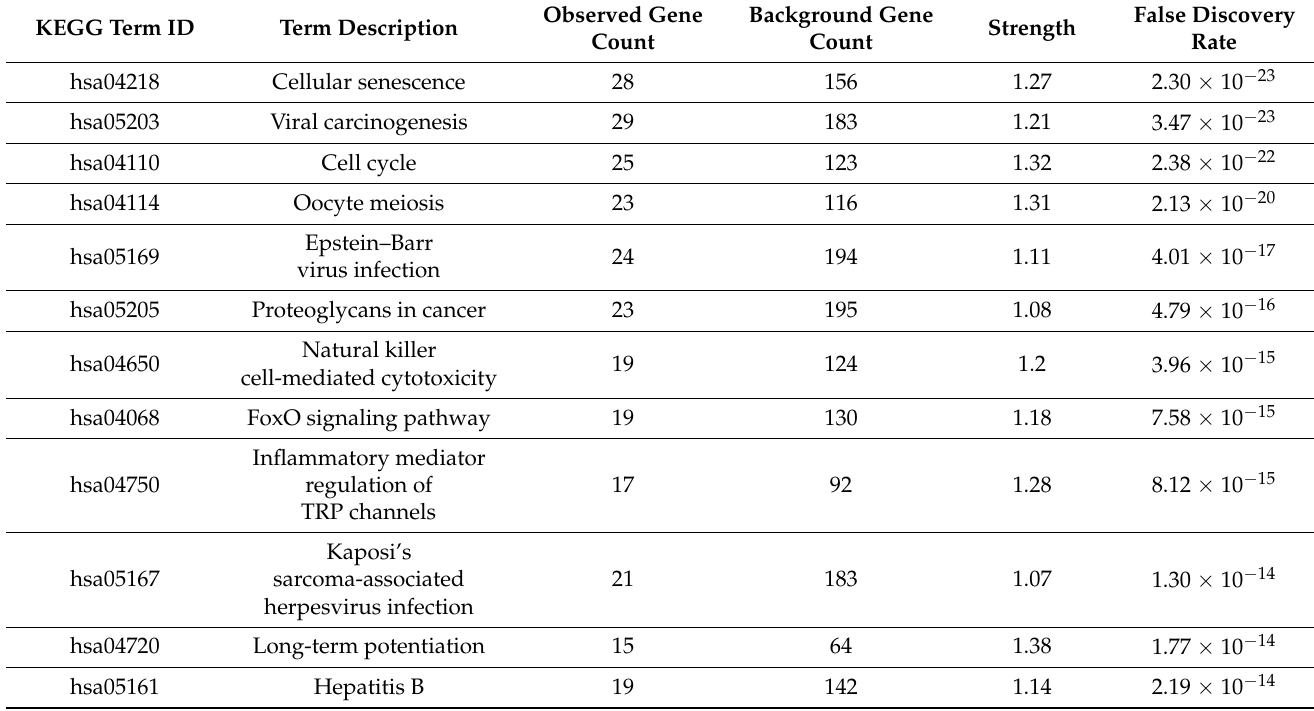
Table A6. Full list of KEGG pathways identified in the STRING analysis of the ERVK integrase